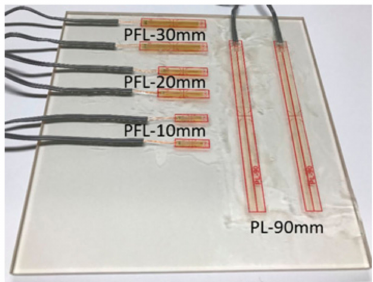
Figure 4. Strain gauges attached to a glass ceramic plate with a very small thermal expansion coe ffi